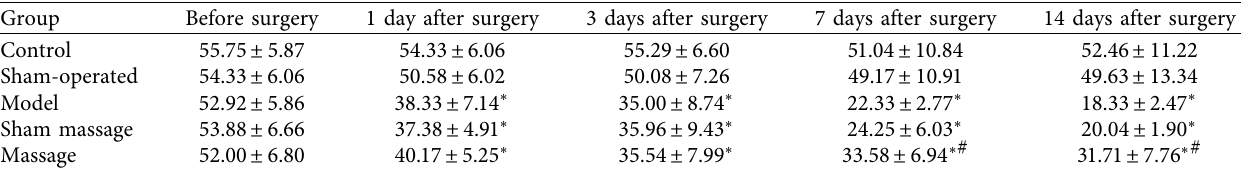
Table 2: PWMTs of the rats. The data are shown as X ± s ( g , n � 8). ∗ P < 0 . 05 compared with the control group; # P < 0 . 05 compared with the model group.